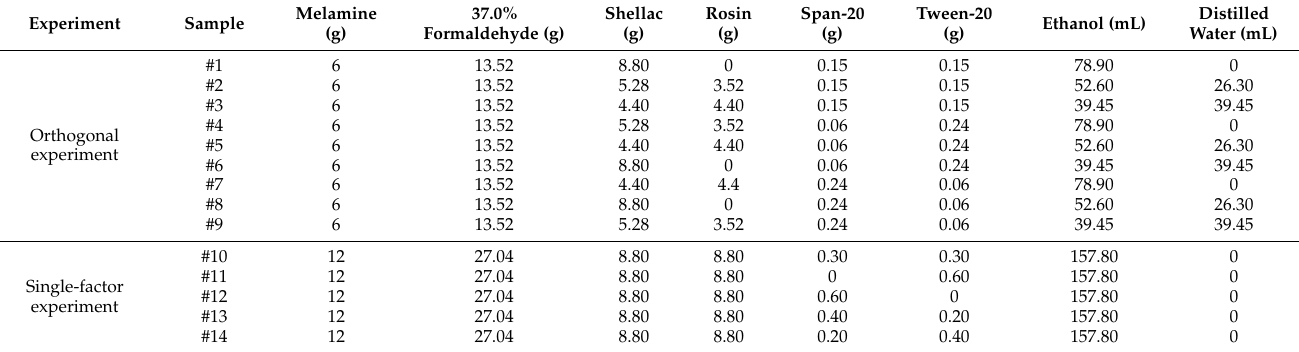
Table 4. A detailed list of the amount of material in the orthogonal and the single-factor